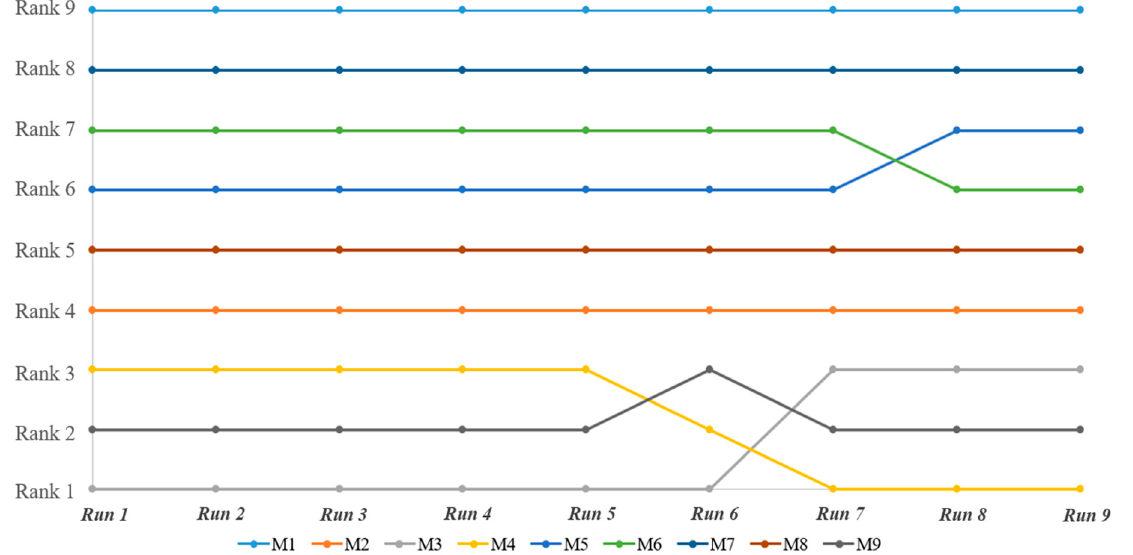
Figure 2. Results of 9 runs of sensitivity analysis.